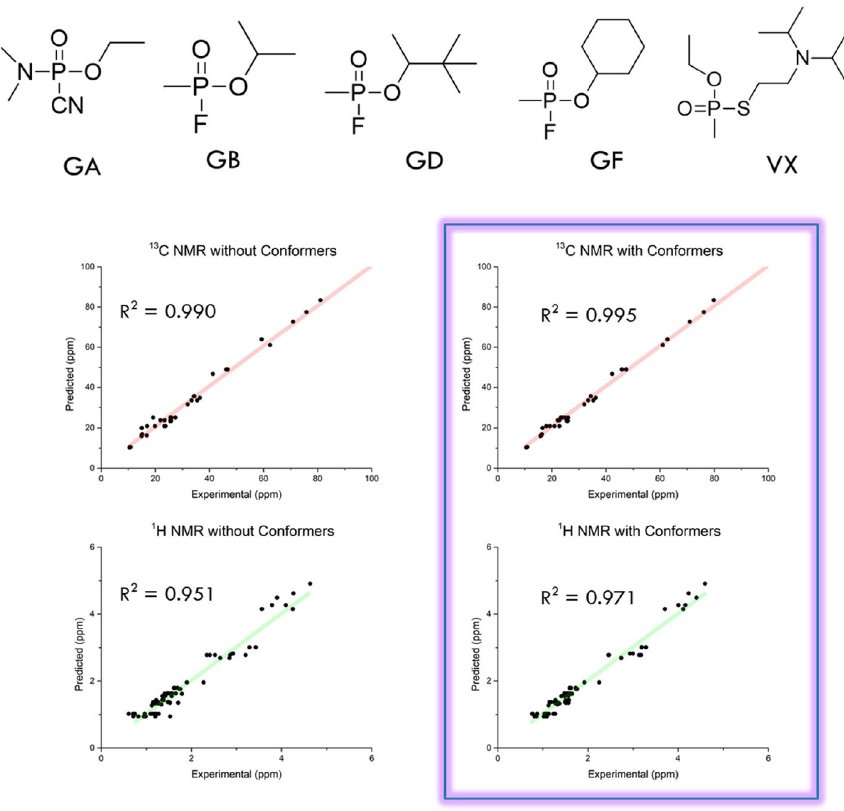
Figure 2. Calculated structures of nerve agents and the 1 H and 13 C NMR chemical shift correlation between experimental and predicted data. Chloroform was used for experimental sampling; therefore, the M06-2X/6-311 + G(2d,p) and MPW1PW91/6-311 + G(2d,p) functionals/basis set combinations were used for the DFT